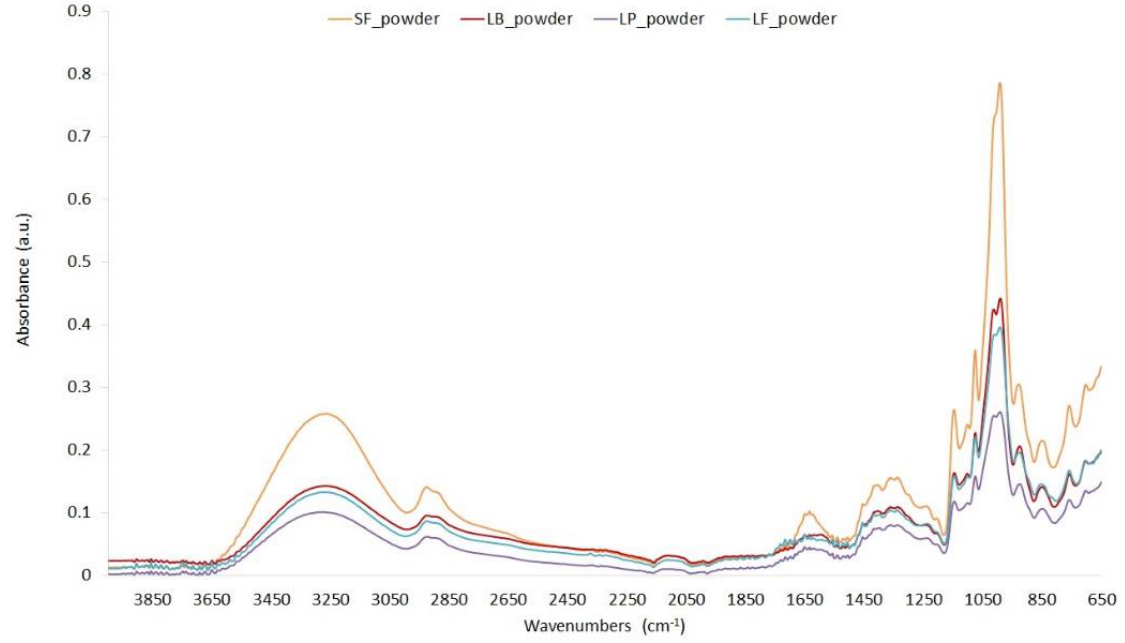
Figure 4. FTIR spectrum of spray dried fermented beetroot powders in the region of 4000 – 650 cm −1 .